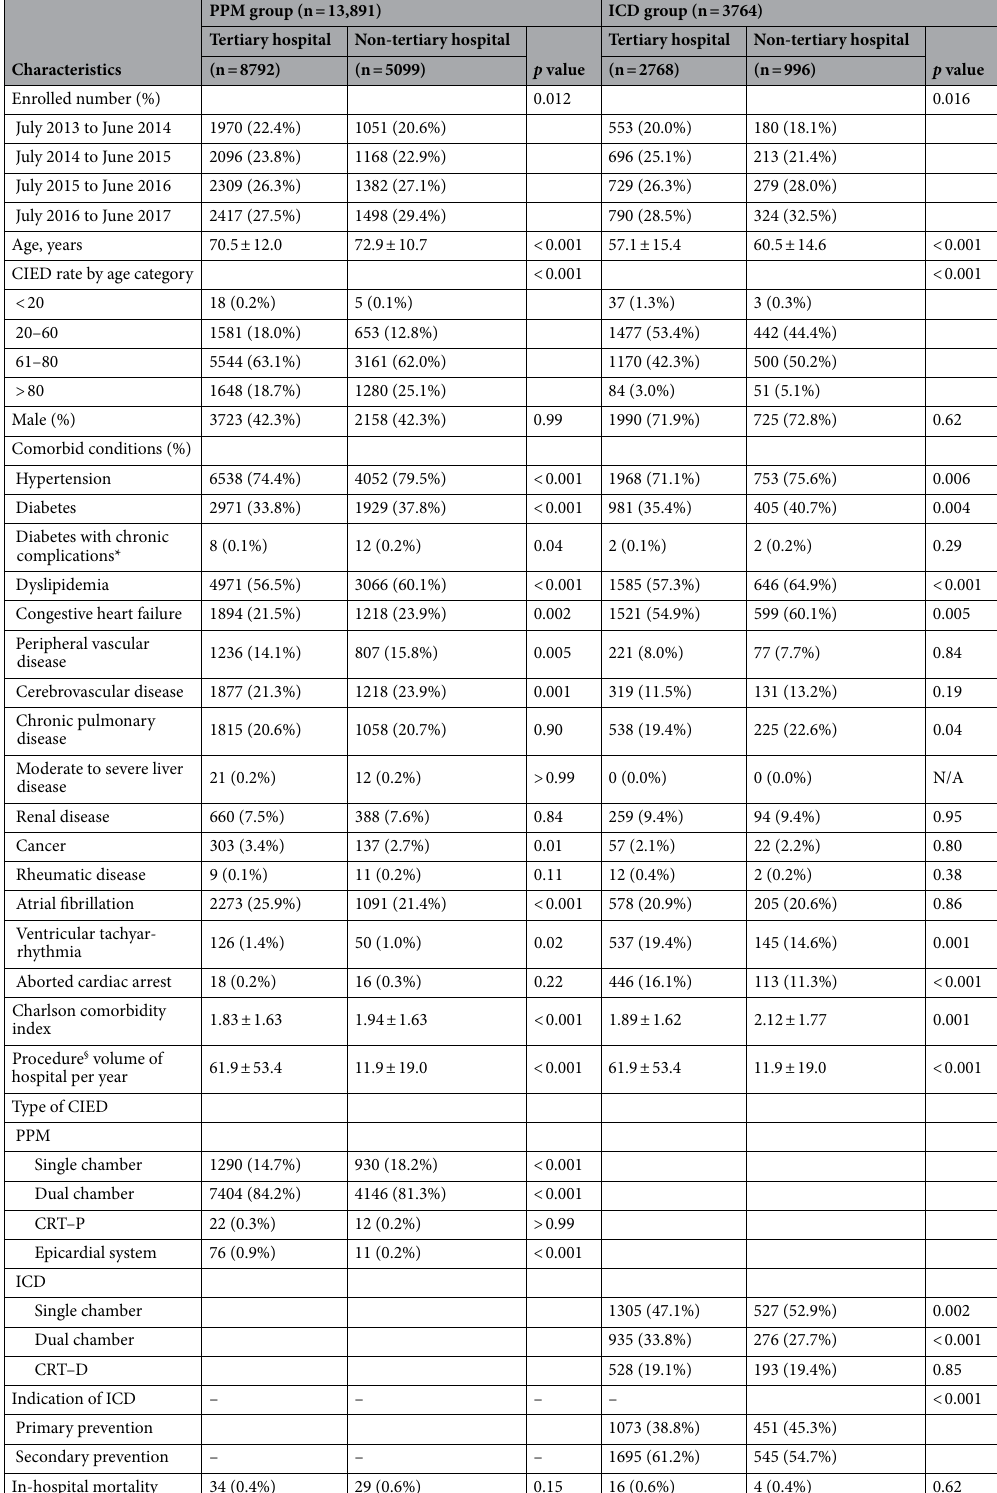
Table 1. Characteristics of patients undergoing new implantation of cardiac implantable electronic device and of hospitals that performed new implantation of cardiac implantable electronic device in tertiary and non-tertiary hospital between 2013 and 2017. Data are reported as mean ± SD or as number (%). CIED, cardiac implantable electronic device; CRT–D, cardiac resynchronization therapy with defibrillator; CRT–P, cardiac resynchronization therapy with pacemaker; ICD, implantable cardioverter-defibrillator; PPM, permanent pacemaker. *Including diabetic nephropathy, retinopathy, or neuropathy. § First and new implantation of CIED including PPM, CRT-P, ICD, and